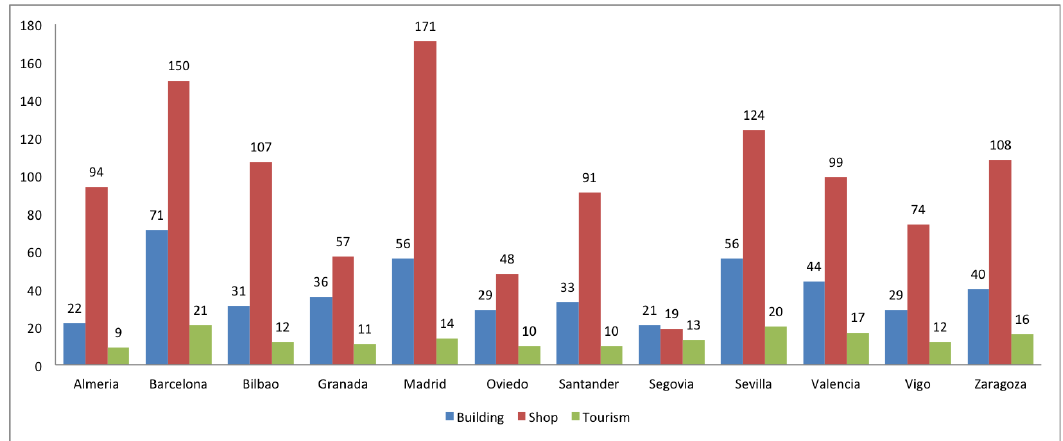
Figure 13. Richness study in Spain. Number of distinct